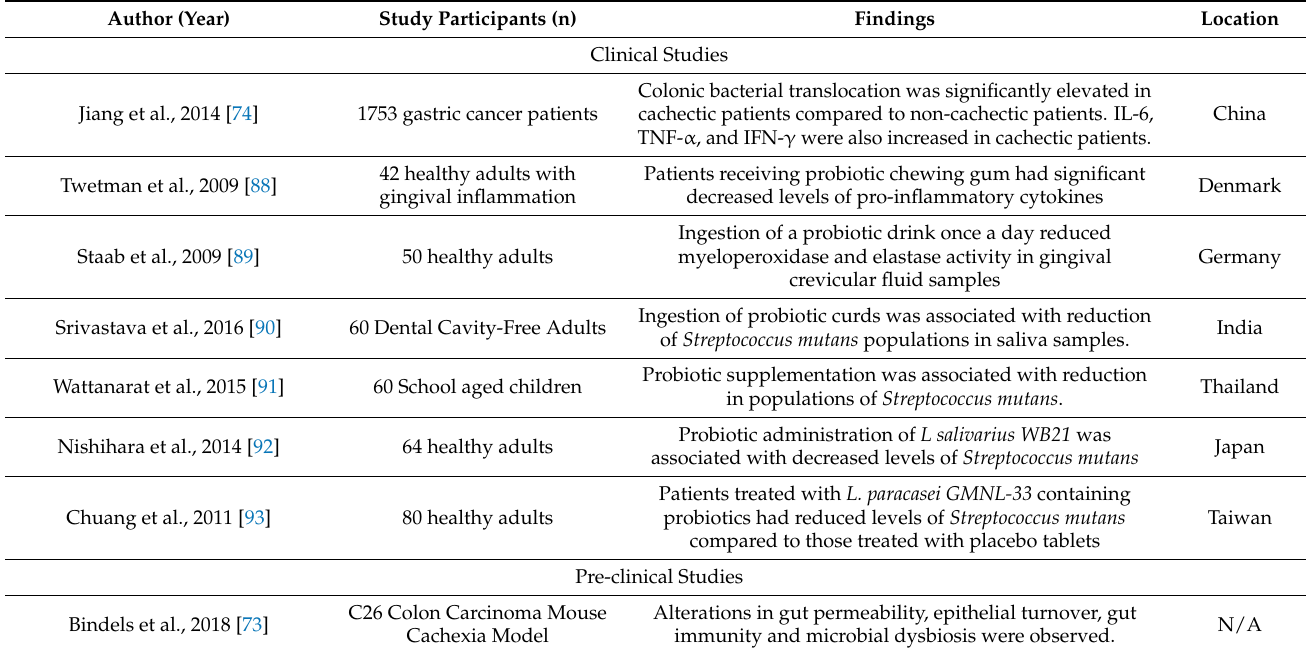
Table 2. The Microbiome and Cancer